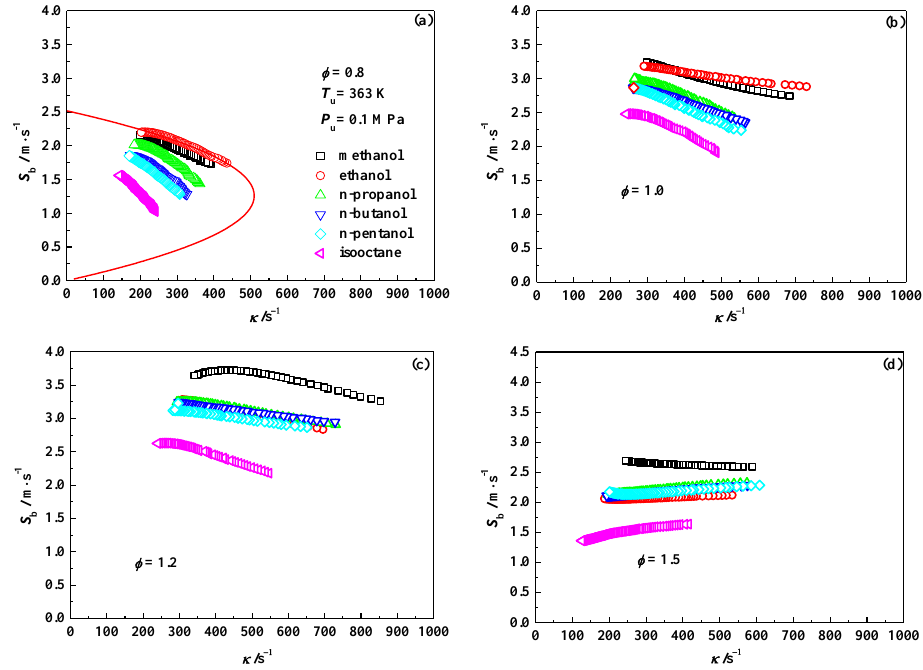
Figure 1. Stretched flame propagation speed vs. stretch rate at different equivalence ratios for pure isooctane and pure C1–C5 primary alcohol flames: ( a ) ϕ = 0.8; ( b ) ϕ = 1.0; ( c ) ϕ = 1.2; and ( d ) ϕ = 1.5. A line is shown in ( a ) to indicate the nonlinear extrapolation.